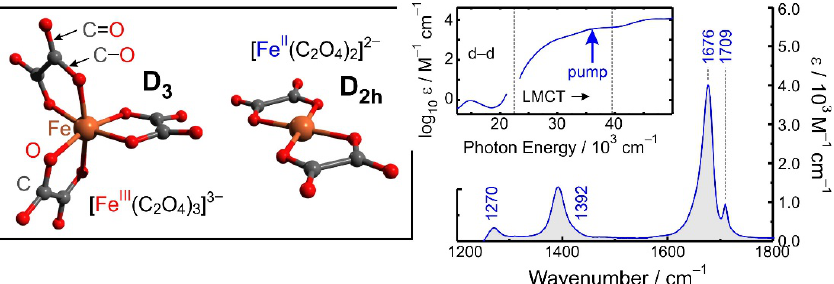
Fig. 1. Left: Optimized molecular structure of the ferrioxalate parent and the ferrooxalate product complex, both from a DFT calculation (B3LYP/def2-TZVP/CPCM(water)). Right: FTIR spectrum and UV/Vi s -spectrum (inset) of aqueous ferrioxalate